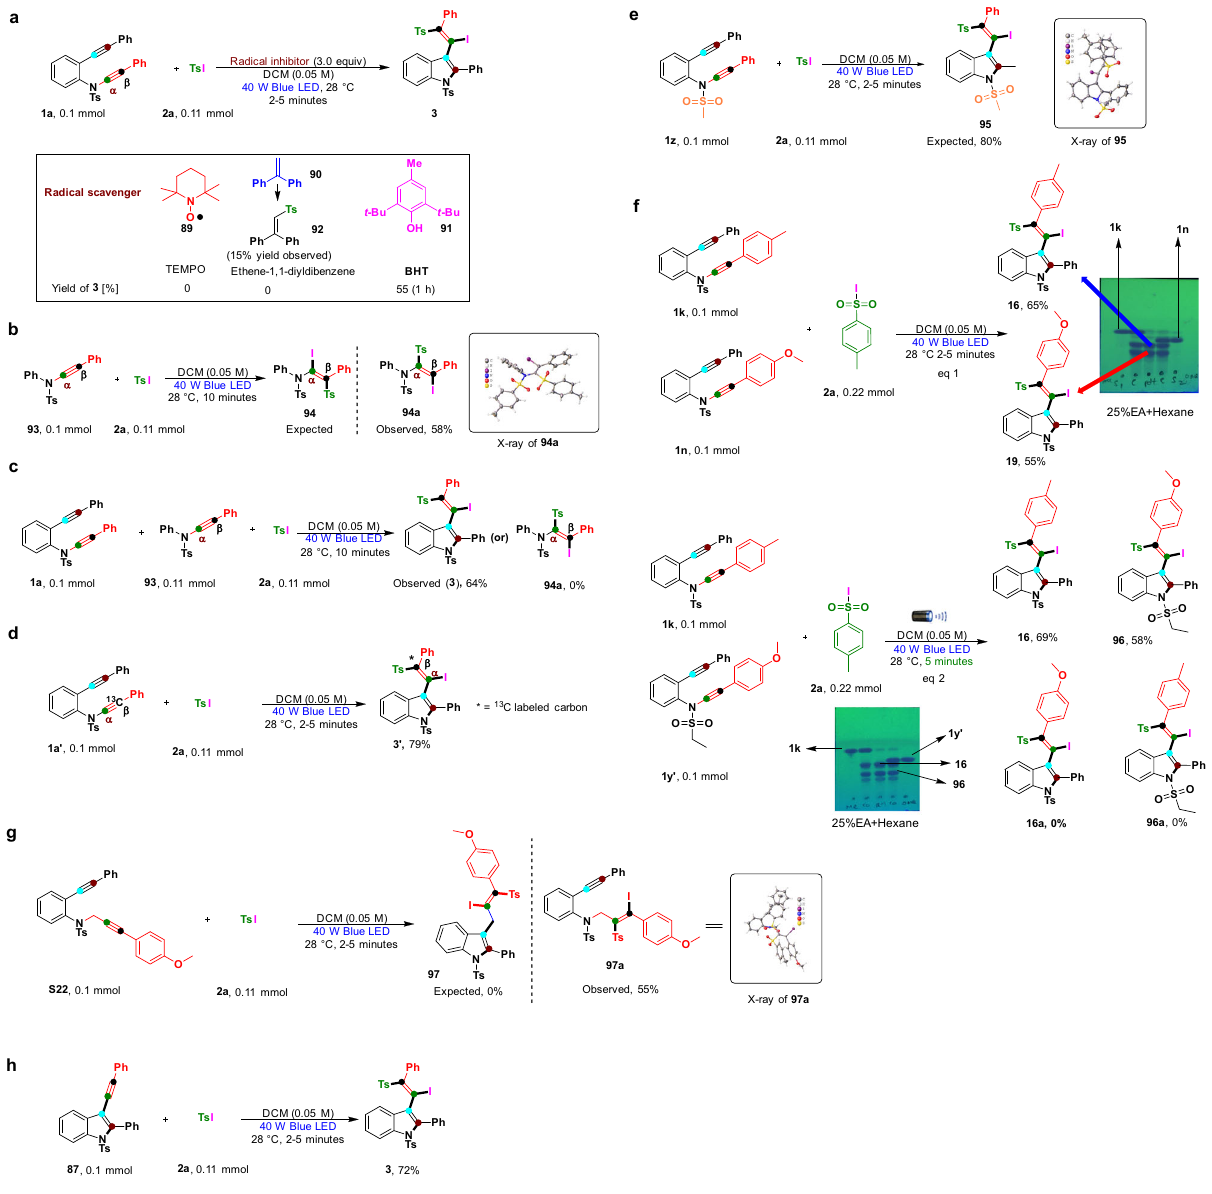
Fig. 8 Mechanistic studies. a Radical inhibition experiments with TEMPO, ethene-1,1-diyldibenzene and BHT. b To determine the importance of the alkynyl group in 2-alkynyl-ynamides ( 1 ), we performed a reaction with simple ynamide 93 . c One-pot strategy for the reactivity comparison of 2-alkynyl-ynamides 1a and simple ynamide with 2a . d 13 C-labeled experiment to identify the in situ reshuf fl ing groups in the transformations with help of 1a ′ with 2a . e Importance of the electron-withdrawing group in the 2-alkynyl-ynamides by replacing N-Ts with N-Ms in ynamide . f Intermolecular or intramolecular alkyne migration was investigated via a crossover experiments. g The carbon-linker length effect was tested by using compounds S22 and 2a . h Reaction tested by using intermediate 2-phenyl-3-(phenylethynyl)-1-tosylindole ( 87 ) with 2a under standard condition.